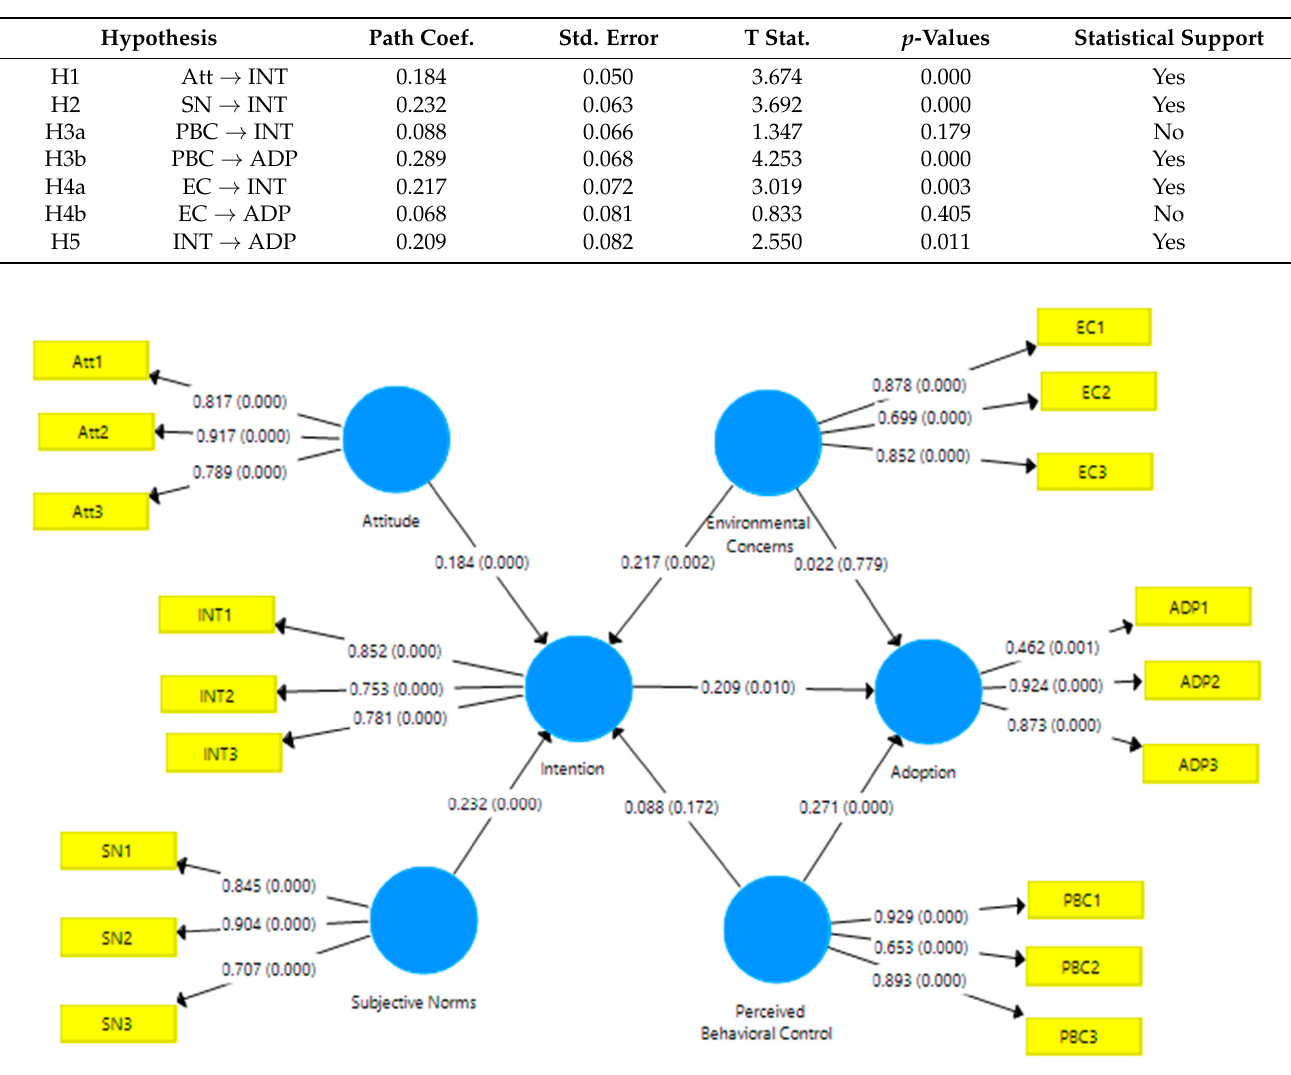
Figure 3. Path diagram for the structural model.